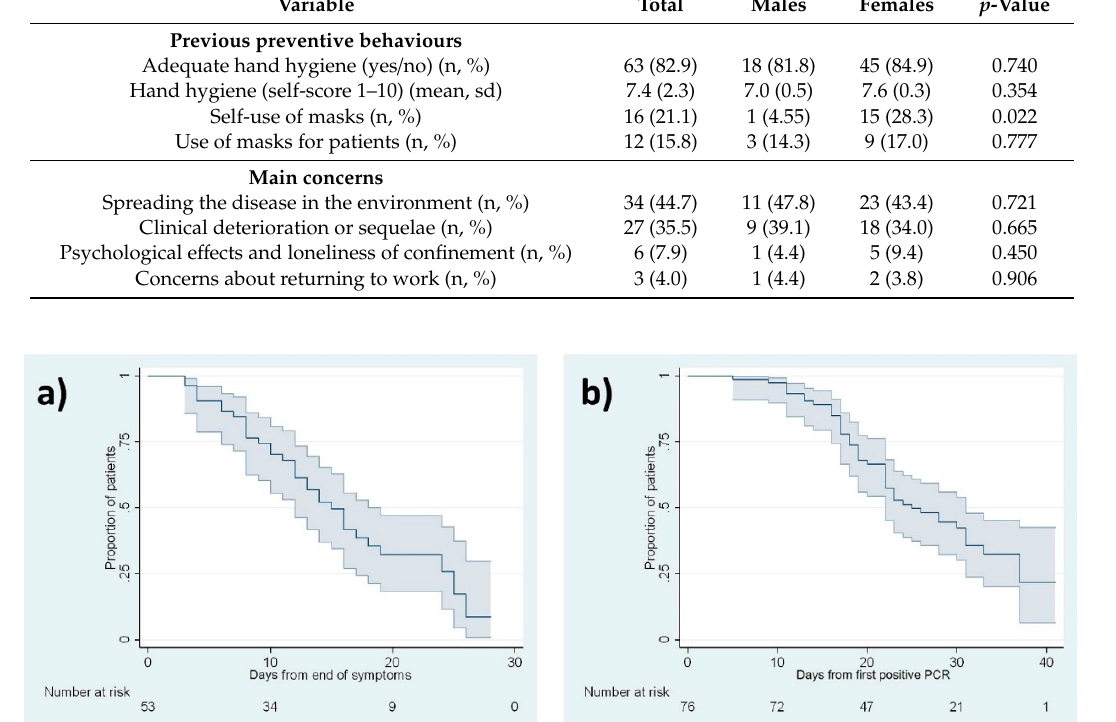
Figure 2. Kaplan–Meier survival analysis curves for negative PCR outcome. ( a ) Days from end of symptoms. ( b ) Days from first positive PCR. Shaded area: 95% confidence interval.